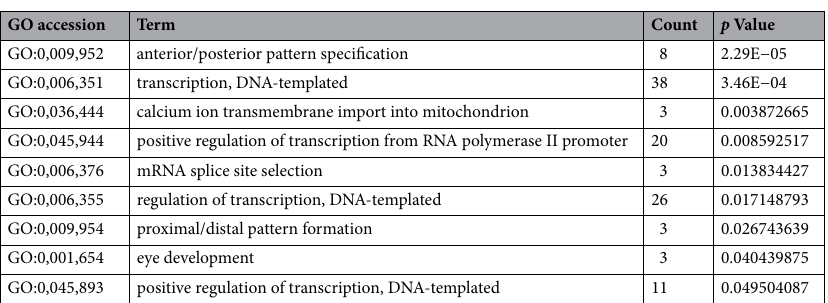
Table 2. GO terms analysis of the nearby protein-coding genes for DE